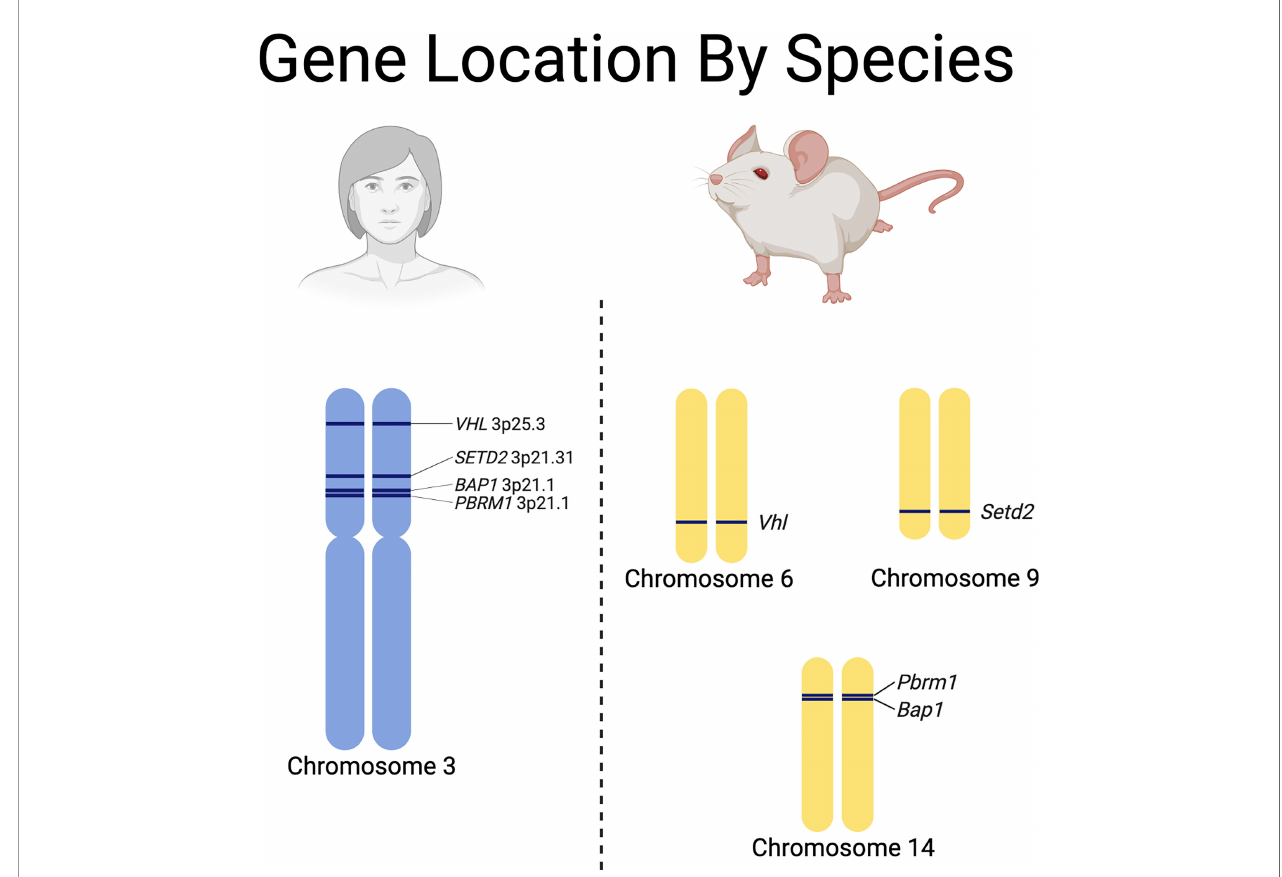
FIGURE 3 | Species speci fi c differences in the chromosomal locations of renal cell carcinoma driver